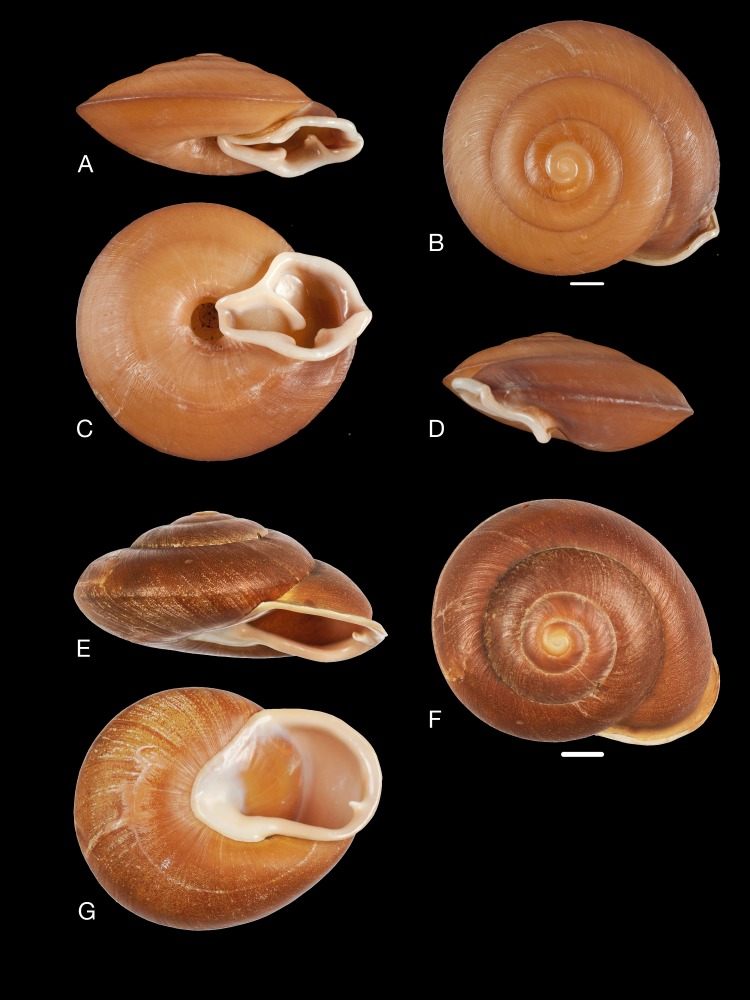
Material collected by the CCP.(A–G) Pleurodontidae. Labyrinthis plicatus (Born, 1780), MNCN 15.05/14208, (A) ventral view, (B) apical view, (C) umbilical view, (D) lateral view (lip); Isomeria aequatoriana (Hidalgo, 1867), MNCN 15.05/3170, (E) ventral view, (F) apical view, (G) umbilical view. Scale line 5 mm (A–D), 1 cm (E–G).